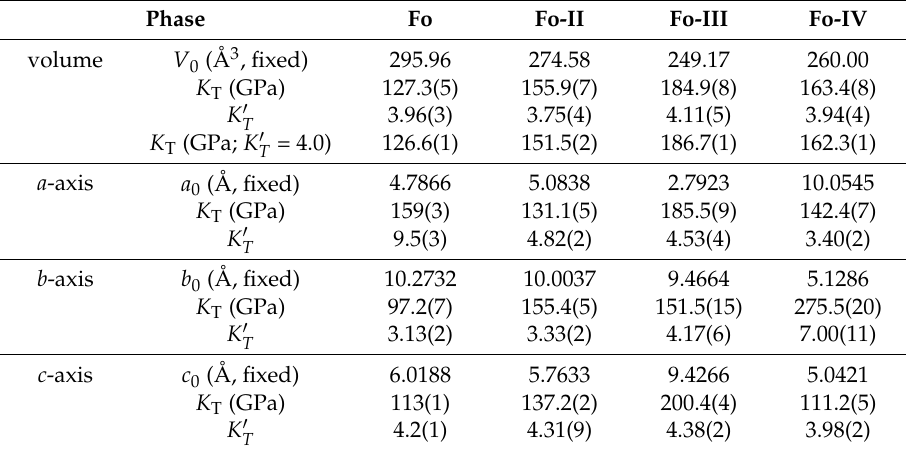
Table 4. Parameters of 3rd BM-EoS for Fo, Fo-II, Fo-III and Fo-IV at 0